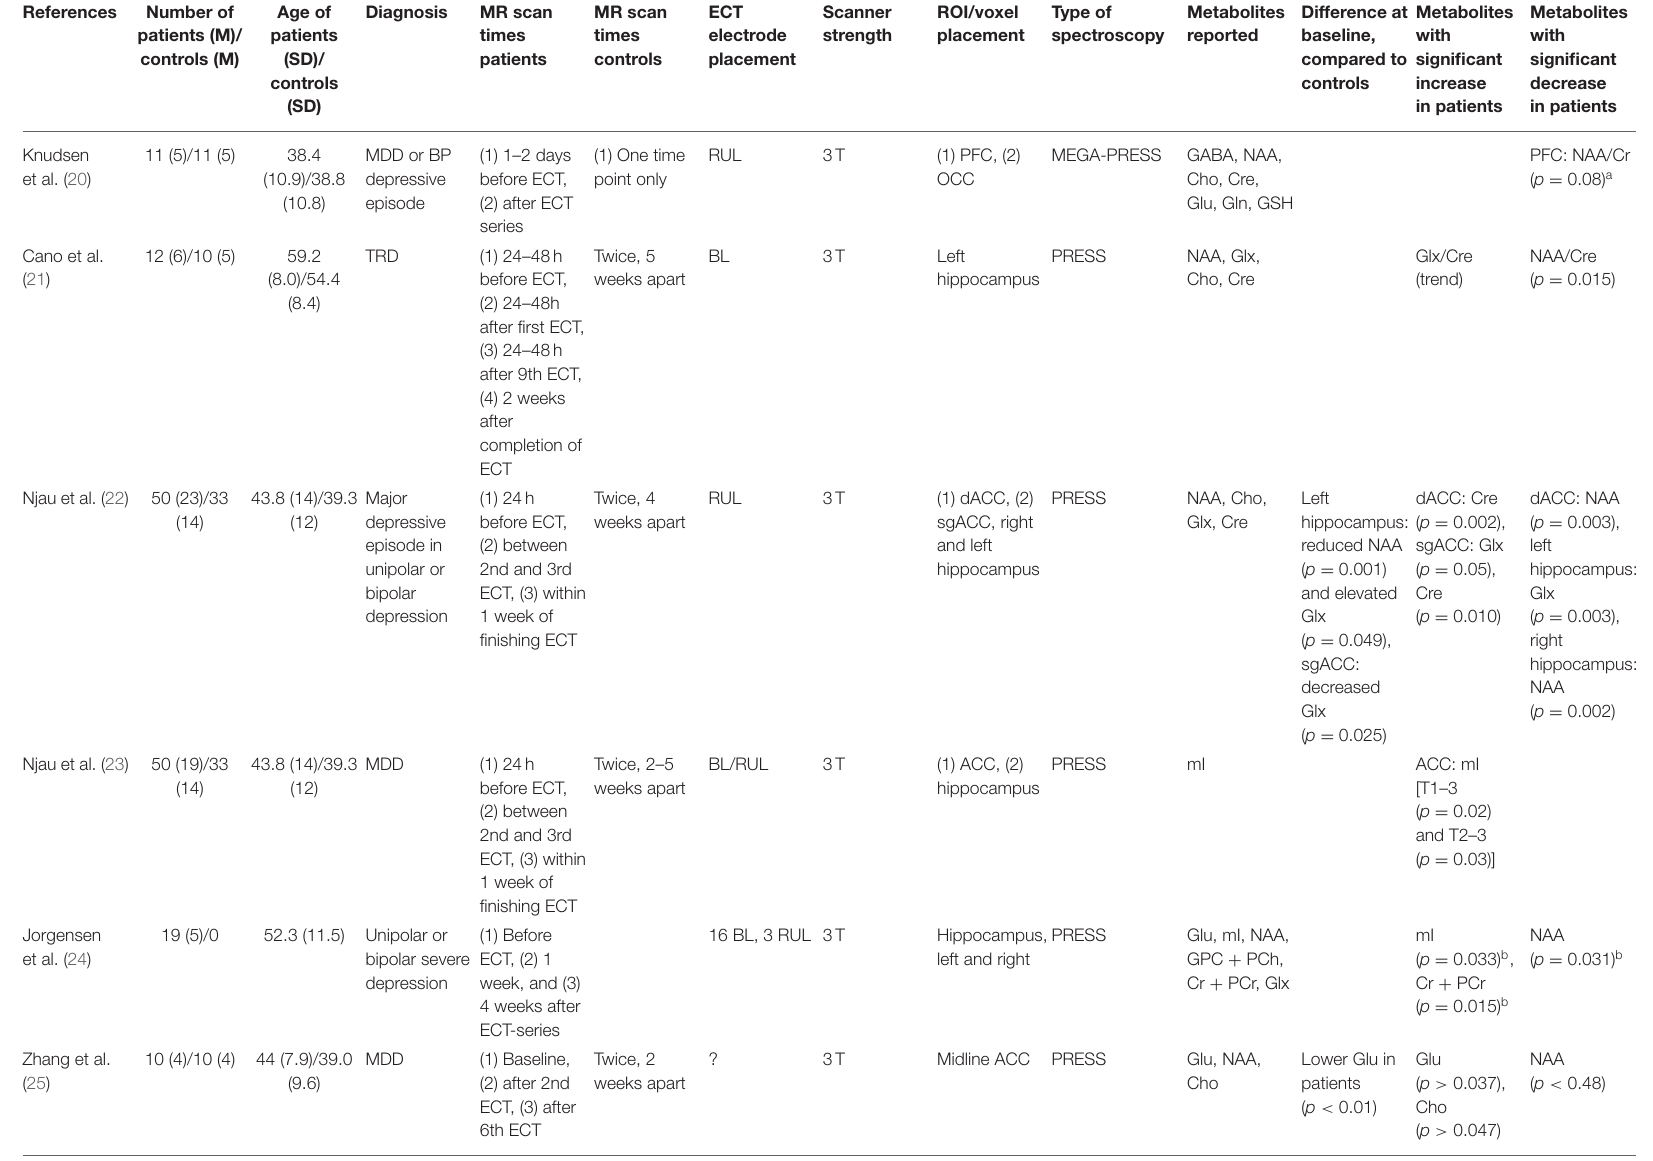
TABLE 1 | Overview of all original investigations that were included in the systematic